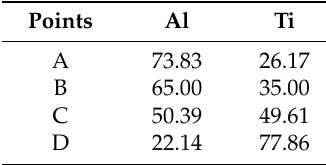
Figure 9. Oxidation kinetics curves of Ti alloy with and without coating at 1073 K for 100 h (10 cycles). 4. Conclusions. 